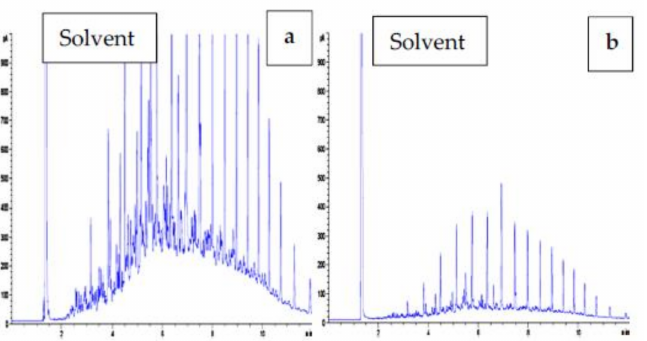
Figure 10. Comparative chromatograph of ( a ) contaminated non-rhizosphere (CN) and ( b ) contami- nated rhizosphere (4% oily sludge with C. cajan ) after 90 days.